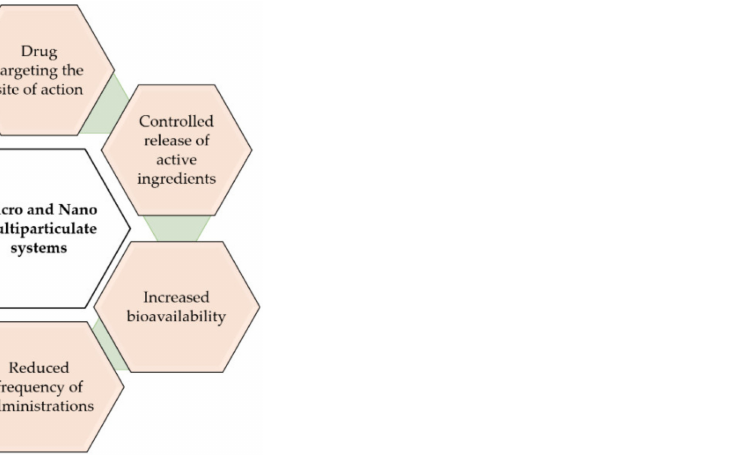
Figure 3. Advantages of multiparticulate drug delivery systems compared to conventional medica-